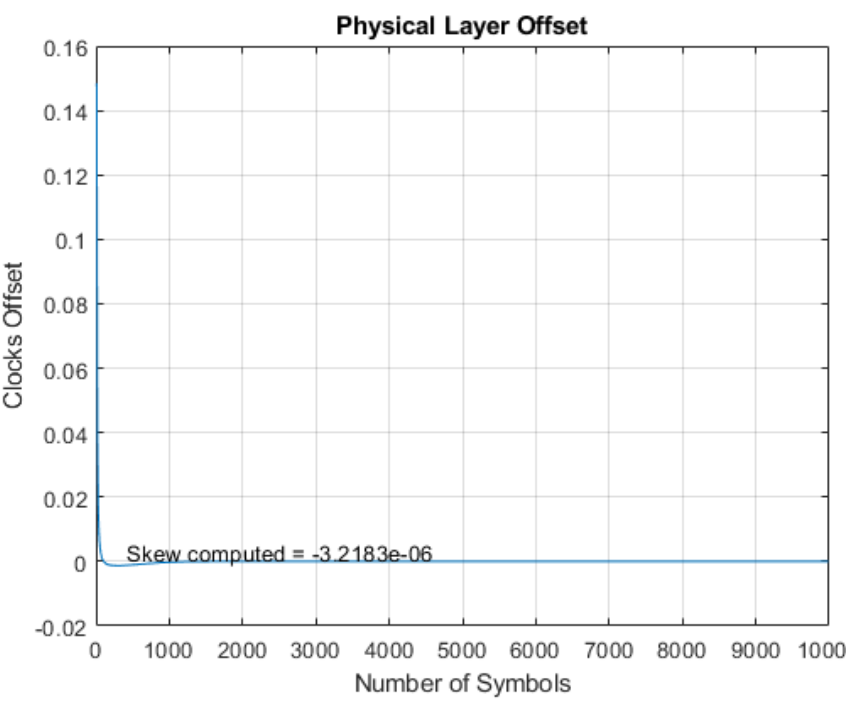
Figure 12. Computation of skew offset using the LS